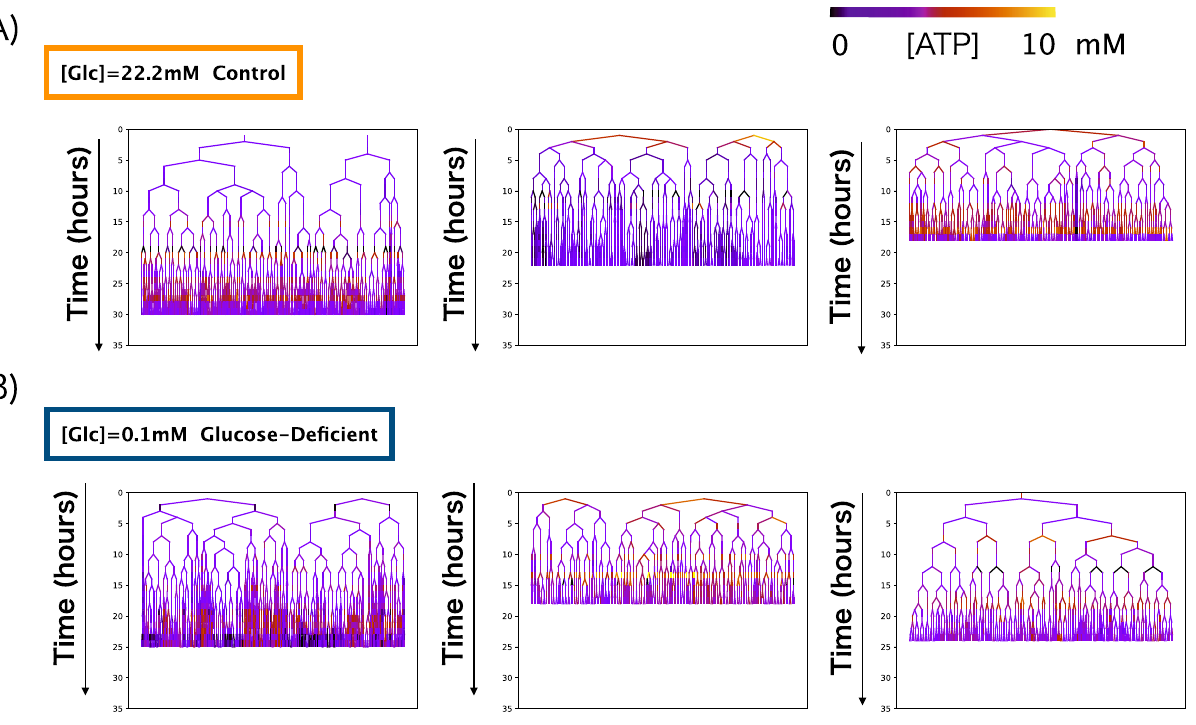
Figure 2. Cell lineages of individual microcolonies under control and glucose-deficient conditions. Cellular lineages acquired by using our custom microfluidic device under ( A ) control conditions (22.2 mM glucose, n = 3) and ( B ) glucose-deficient conditions (0.1 mM glucose, n = 3). The colors indicate the intracellular ATP concentrations of individual cells along a 0- to 10-mM